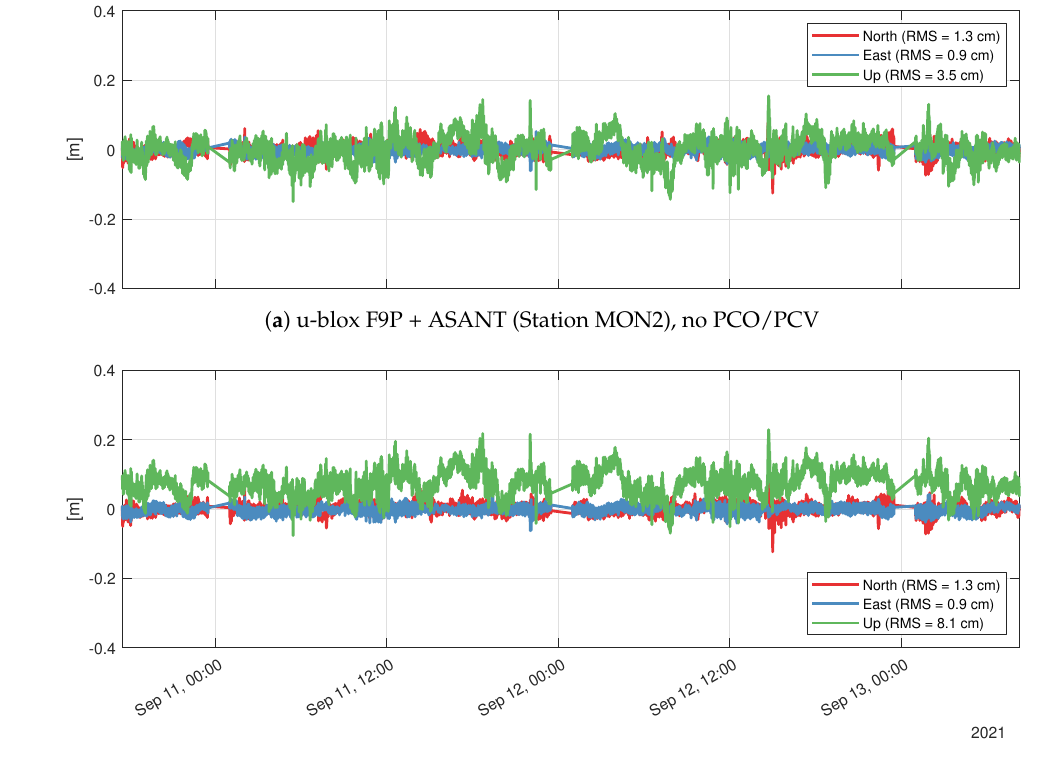
Figure 15. Session 2: results for the kinematic displacements obtained from the static experiments: PPP-AR solutions computed with raPPPid with/without PCO/PCV corrections. Top plot: no PCOs/PCVs corrected. The topocentric coordinates were computed with the biased reference coordinates. Bottom plot: no PCOs/PCVs corrected. The topocentric coordinates were computed with the unbiased reference